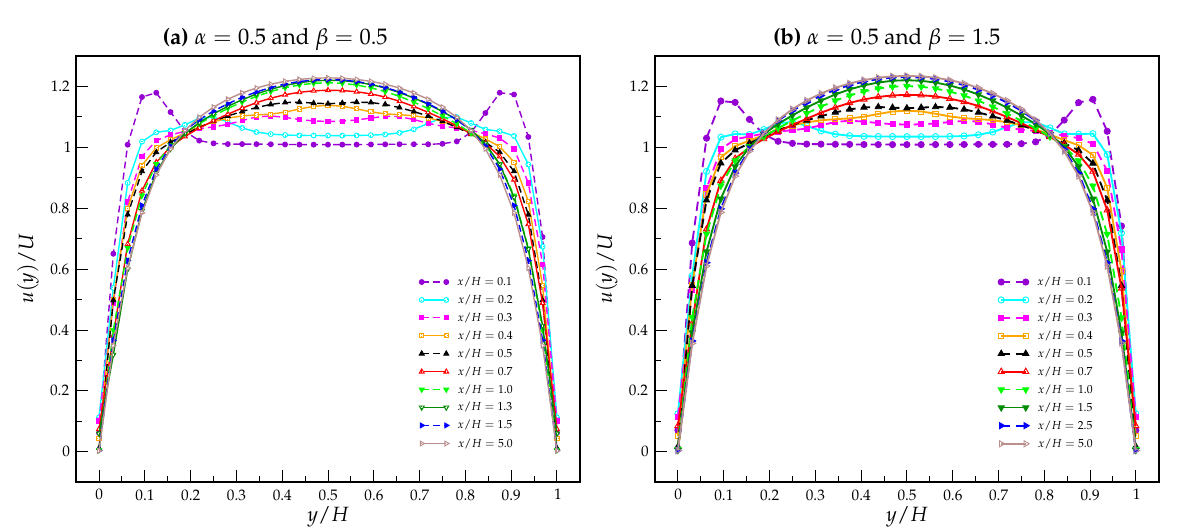
Figure 11. Velocity profiles obtained at 10 different sections of the channel for Wi = 1.0. (a) α = 0.5, β = 0.5; (b) α = 0.5, β = 1.5.